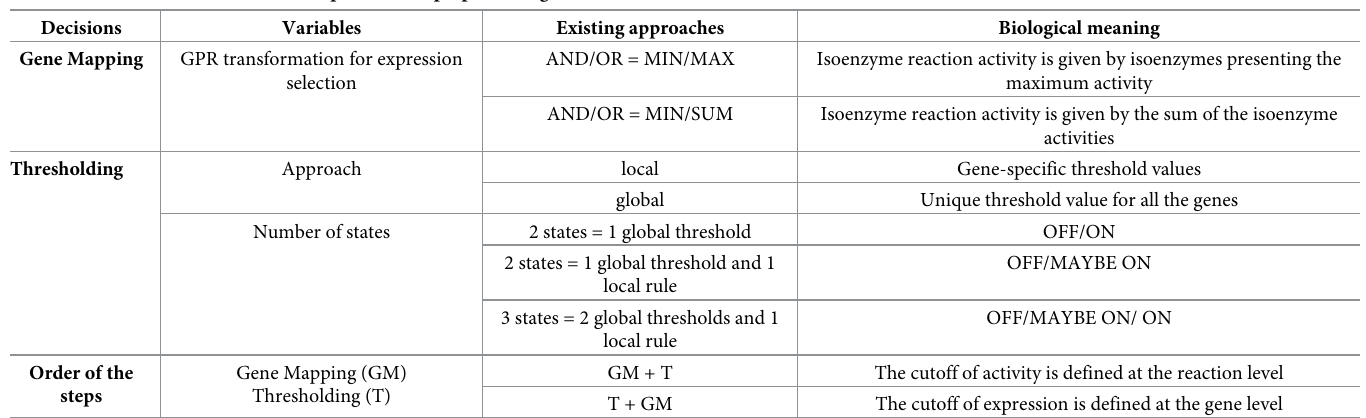
Table 1. Decisions involved in transcriptomic data